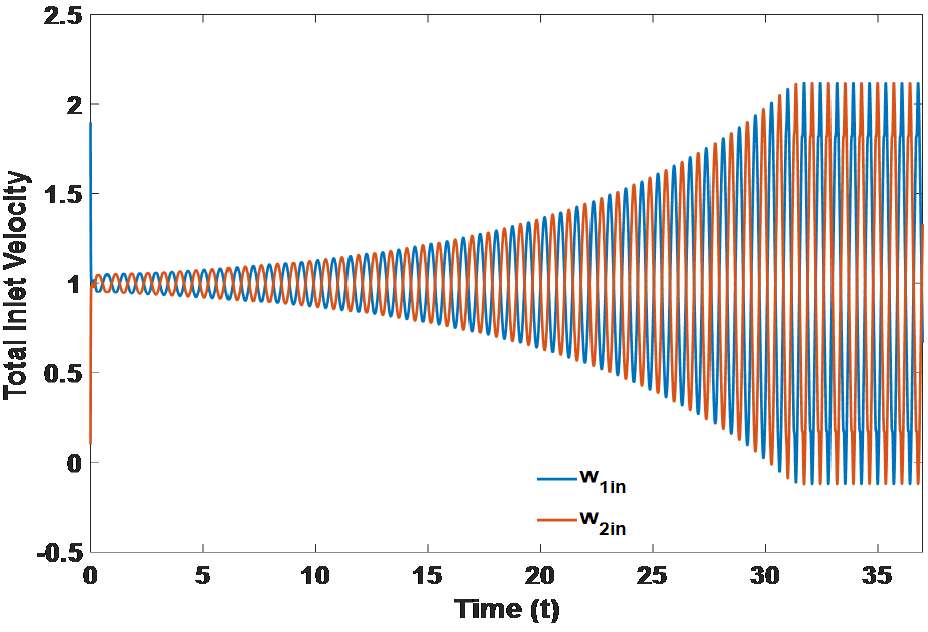
Figure 12. Existence of supercritical Hopf bifurcation.